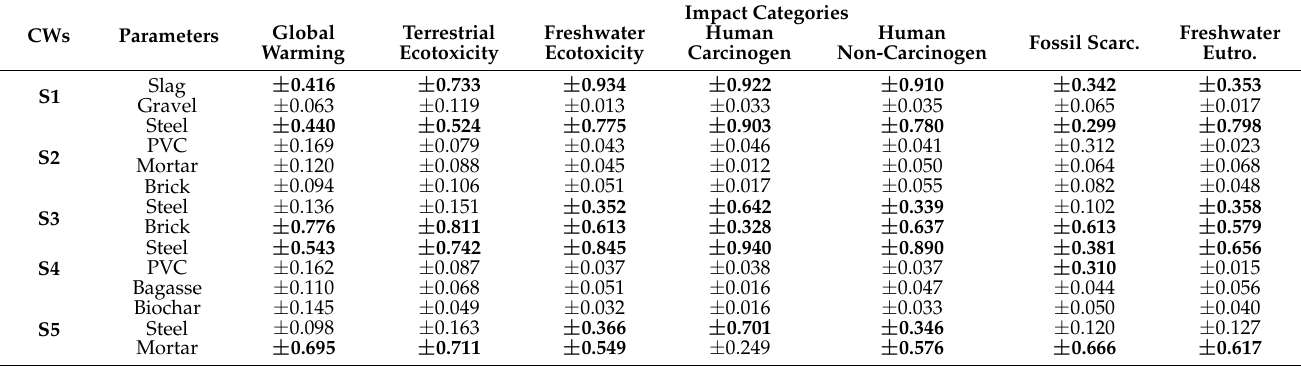
Table 4. Impact categories influenced by varying ± 10% of the selected inventory